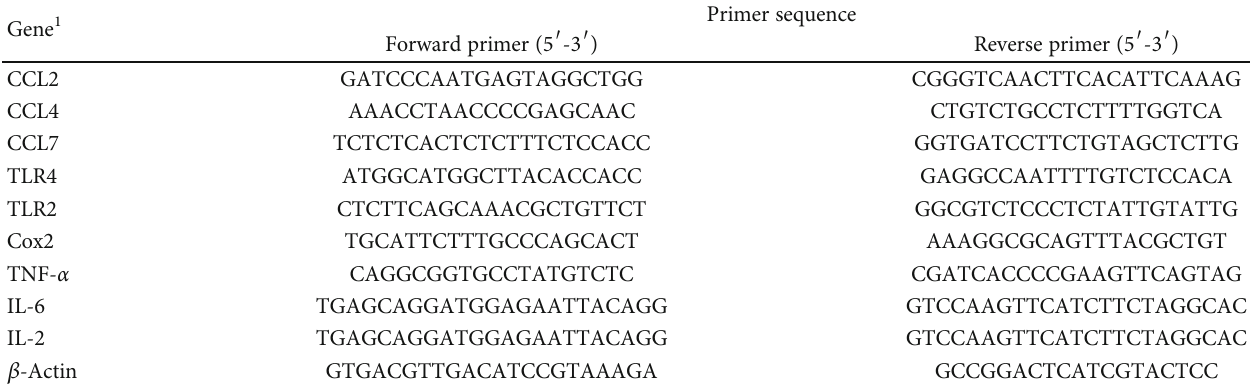
Table 1: The primer sequences used in this